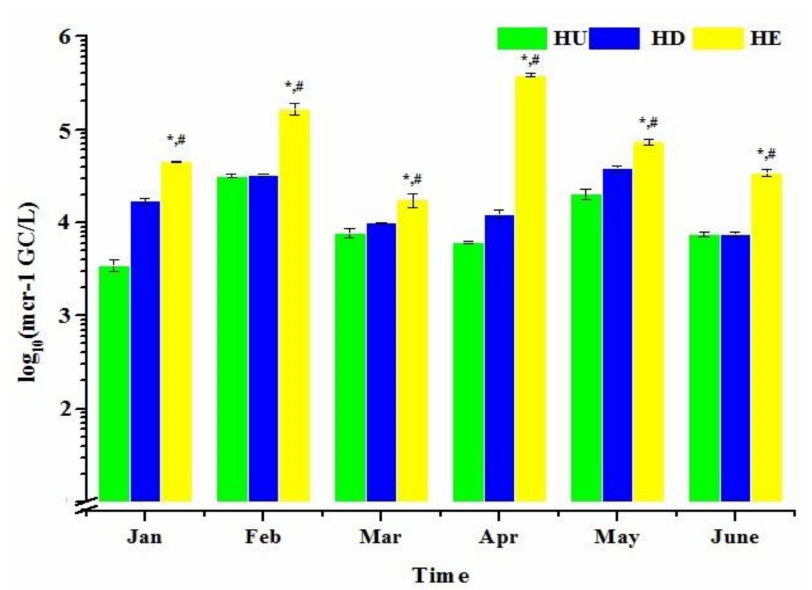
Figure 5. The number of mcr-1 in water samples. Average of three reactions is shown and error bars indicate standard deviations. The abundance of mcr-1 was significantly related to site (ANOVA, the abundance of mcr-1 at site HE have significant different with either HU (* p = 0.001, <0.05) or HD ( # p = 0.011, <0.05) in each month). (Site HU: upstream of the urban region, 39 ◦ 10.316’ N, 117 ◦ 05.395’ E, site HD: downstream of the urban region, 39 ◦ 01.231’ N, 117 ◦ 27.344’ E, site HE: estuary of the Haihe River, 39 ◦ 04.386’ N, 117 ◦ 18.698’